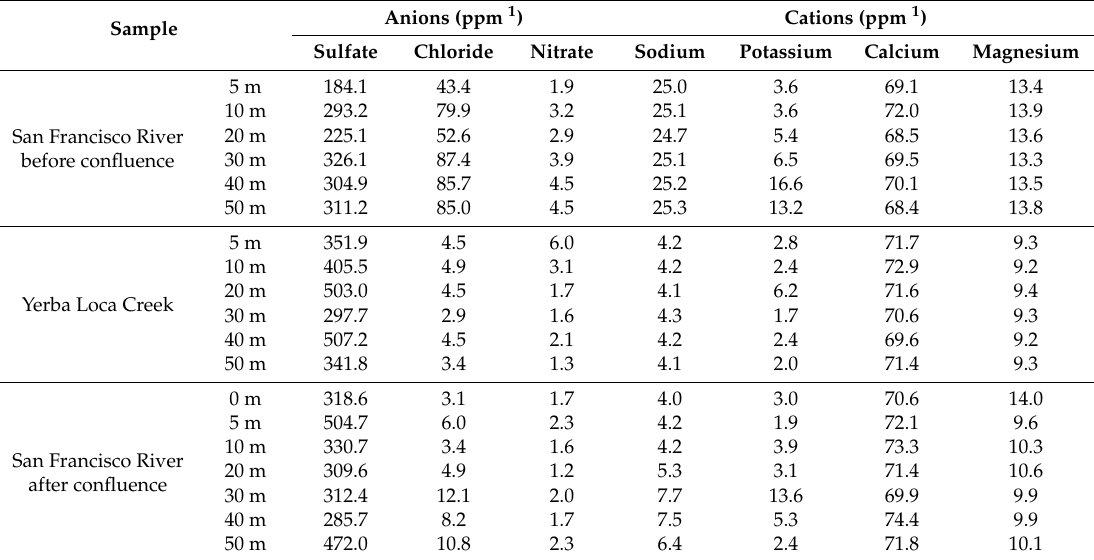
Table 1. Concentration of anions and cations in water